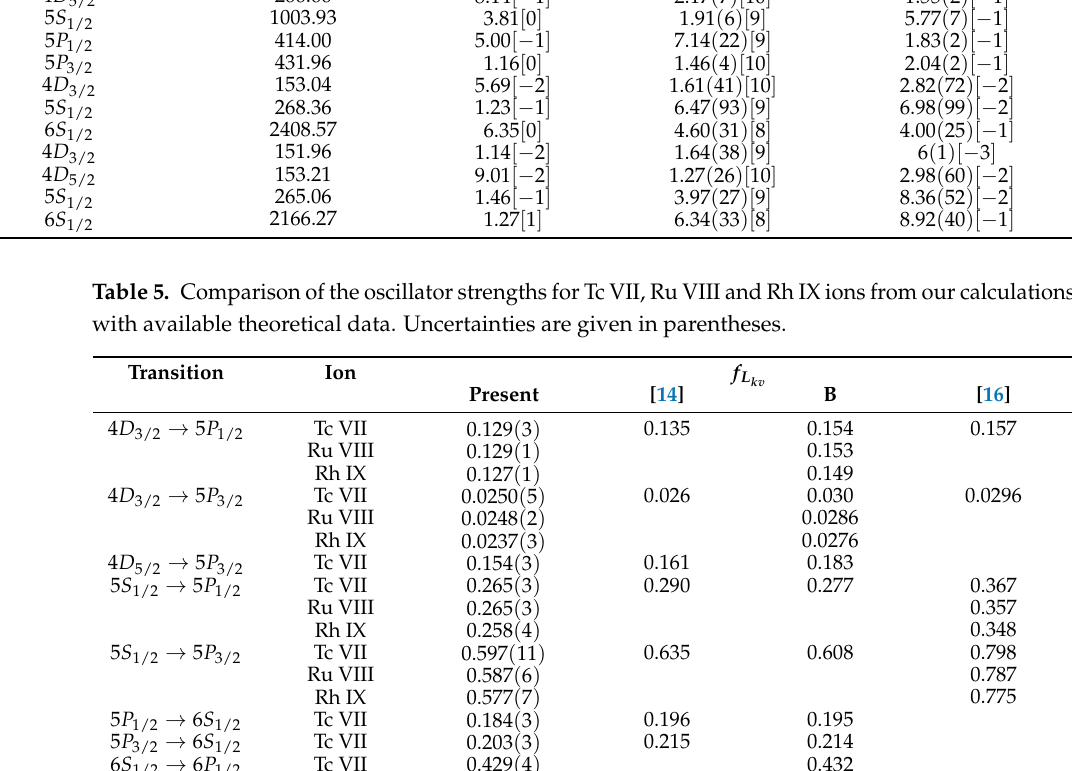
) (in a.u.), wavelengths ( λ ) (in Å), transition probabilities vk ) for the Rh IX ion through E1 decay channel. kv